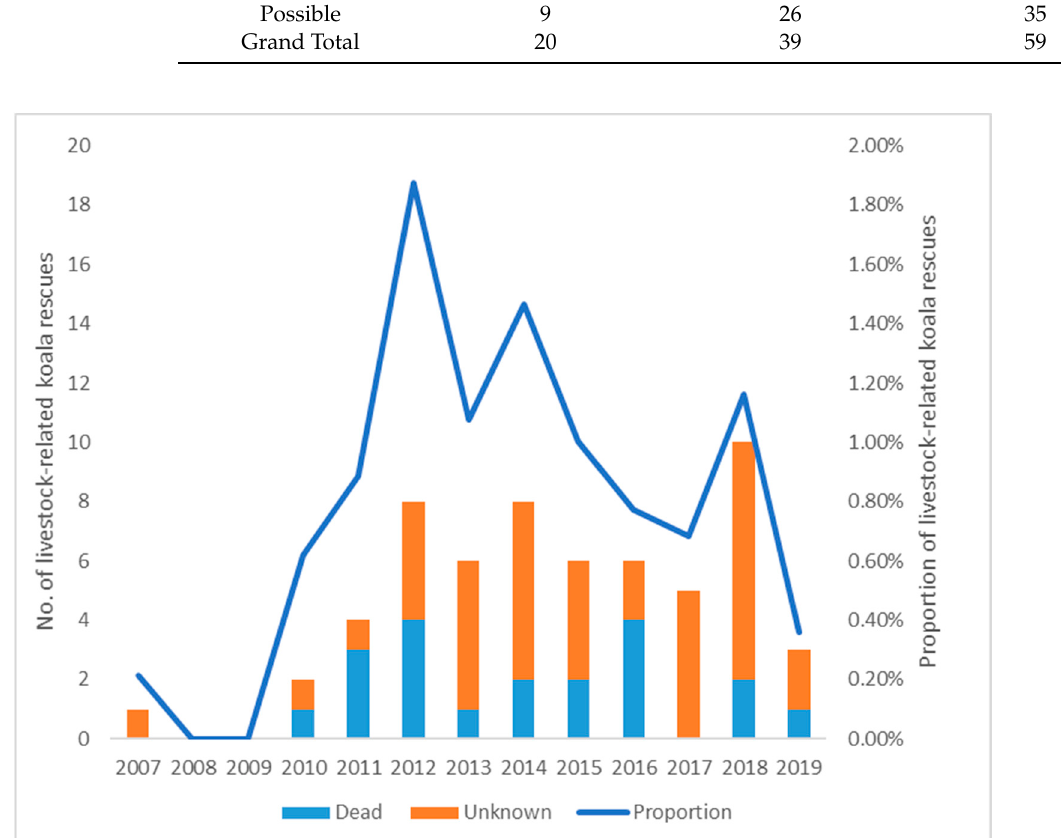
Figure 4. The number of livestock-related koala rescues with their outcomes and proportion of all koalas rescued by Wildlife Victoria each year from 2007 to 2019.